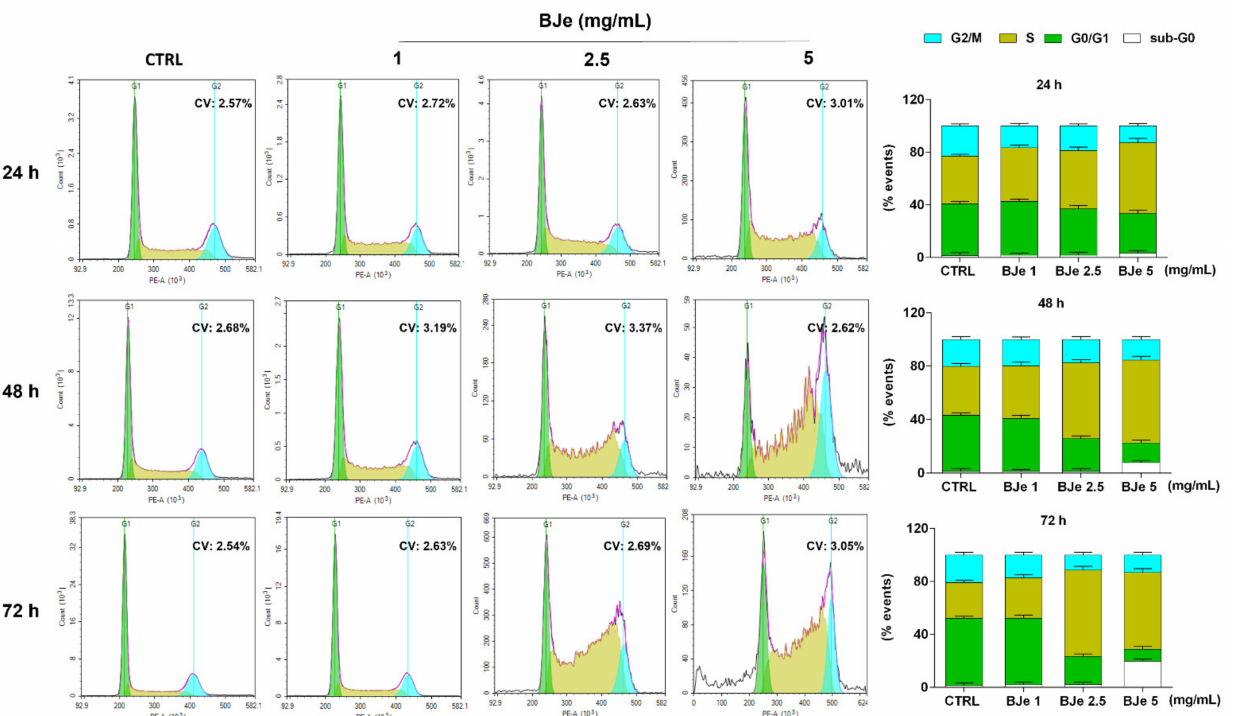
Figure 4. Influence of BJe on cell cycle distribution of THP-1 cells. Progression of THP-1 cells through the cell cycle phases was assessed by cytofluorimetric analysis after exposure to BJe (1–5 mg/mL) for 24, 48 and 72 h. Representative plots of three different experimental sessions of PI staining performed in triplicate ( n = 9) are shown (on the left ), along with the coefficient of variation (CV) value. Histograms report the percentage of cells present in sub G0 (white bar), G0/G1 (green bar), S (dark yellow bar), and G2/M (cyan bar) phases, expressed as the mean ± SEM of three independent experiments performed in triplicate ( n = 9) (on the right